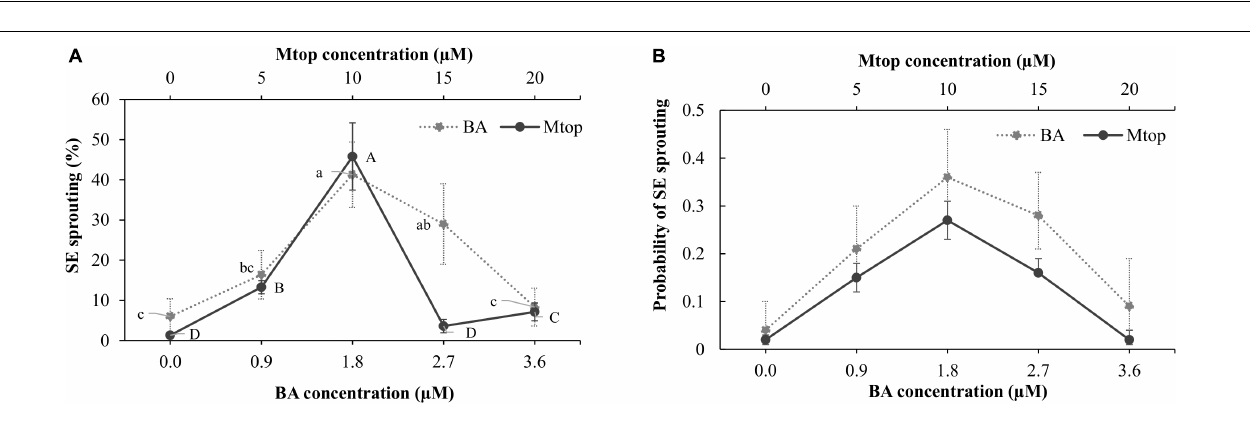
FIGURE 4 | BA and Mtop concentration effect on the sprouting (A) of hybrid papaya somatic embryos after a 2-month culture and the sprouting probability based on a logistic regression model (B) for each plant growth regulator (BA: Wald t -test: X 2 = 21.2, p ( > X 2 ) = 4.1e − 06 . Model equation: P ( y ) = 1 /( 1 + e ( 3 . 0765 − 2 . 6089x + 0 . 6763x 2 ) ) ; p- value = 5.268642e − 07 and Mtop: Wald t -test: X 2 = 141.6, p ( > X 2 ) = 0.00. Model